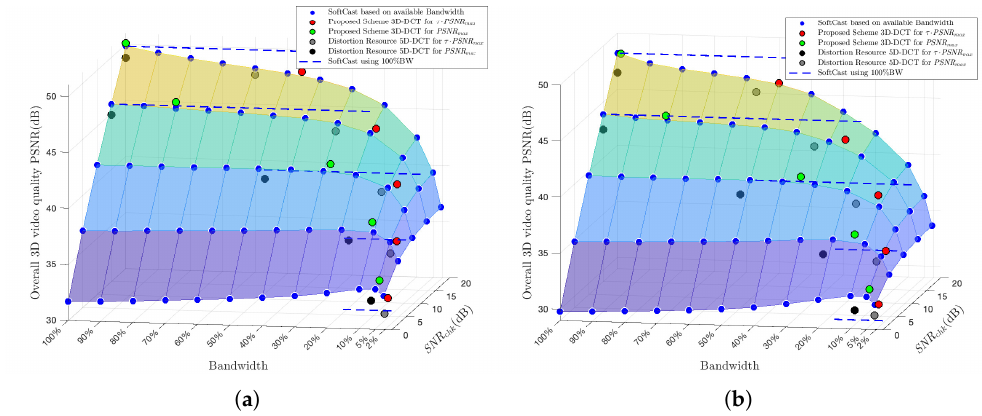
Figure 10. Performance comparison of different schemes under multiple SNR chk and bandwidth values: ( a ) Kendo; ( b )